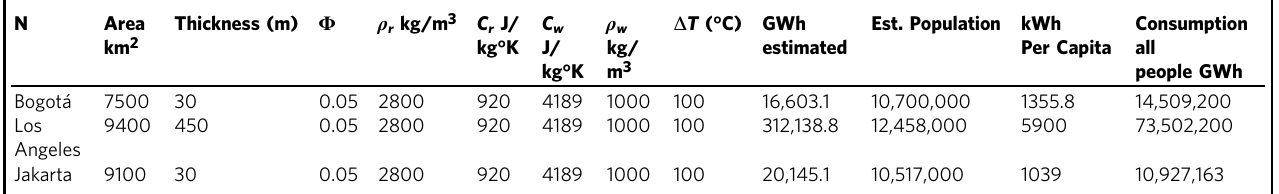
Table 3 Main volumetric parameters used for estimating the energy and information about the total energy per capita consumed by all inhabitants for these